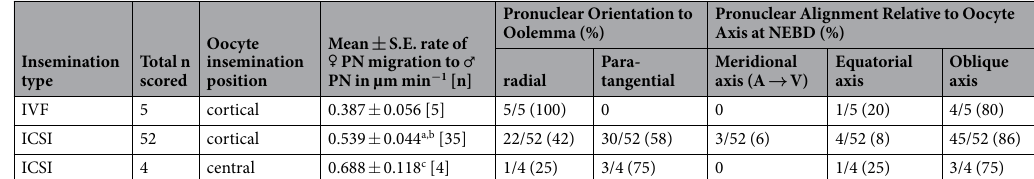
Table 1. NHP Pronuclear Migration, Cortical Alignment and Orientation to Zygotic Axes Analyzed from TLVM Recordings. a female pronuclear migrate rate not significantly different between ICSI cortical versus IVF cortical sperm (p < 0.27). b female pronuclear migration rate not significantly different between ICSI cortical versus ICSI central sperm (p < 0.61). c female pronuclear migration rate not significantly different between ICSI central versus IVF cortical sperm (p <